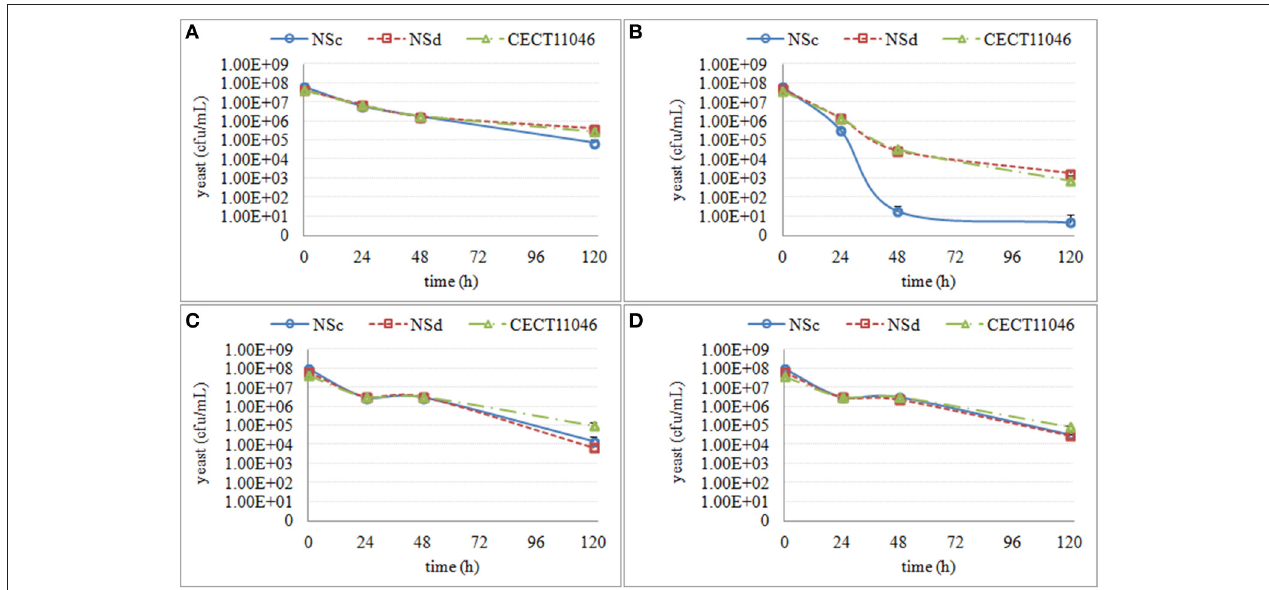
FIGURE 5 | The culturable population of three S. bacillaris strains (NSc, NSd and CECT11046) grown in different synthetic media for 120h. (A) the growth in supernatant from the second stage of S. cerevisiae fermentation S-2 (B) the growth in supernatant from the third stage of S. cerevisiae fermentation S-3 (C) the growth in synthetic media MS-3 (D) the growth in synthetic media